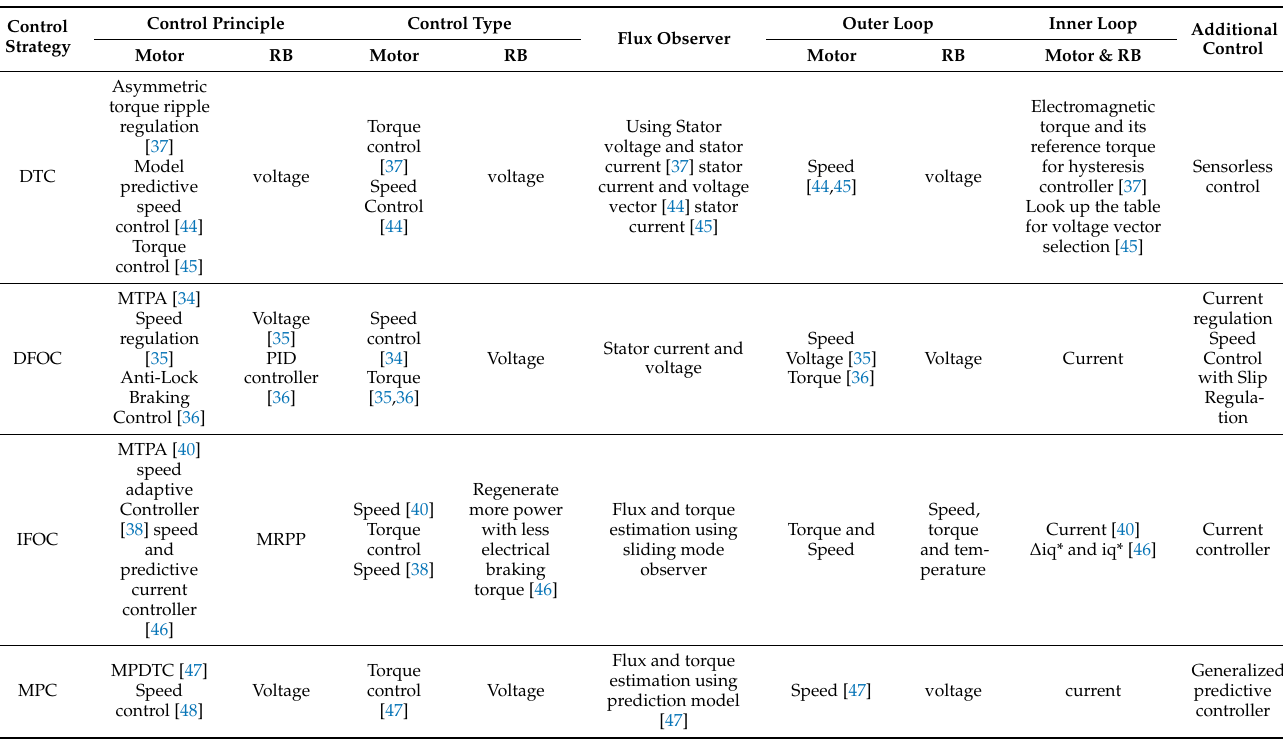
Table 2. Control strategies used in